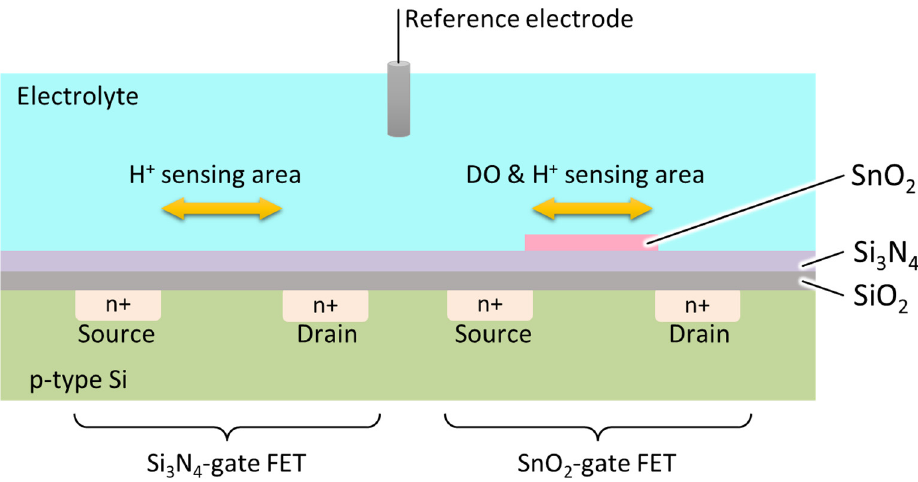
Figure 1. Schematic diagram of the proposed DO-/hydrogen ion-sensitive FET.